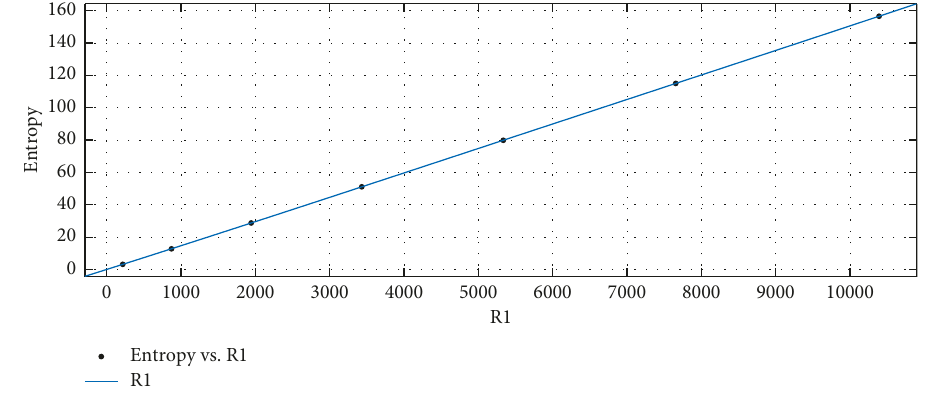
Figure 18: R ( x -axis) vs. Entropy ( y 1